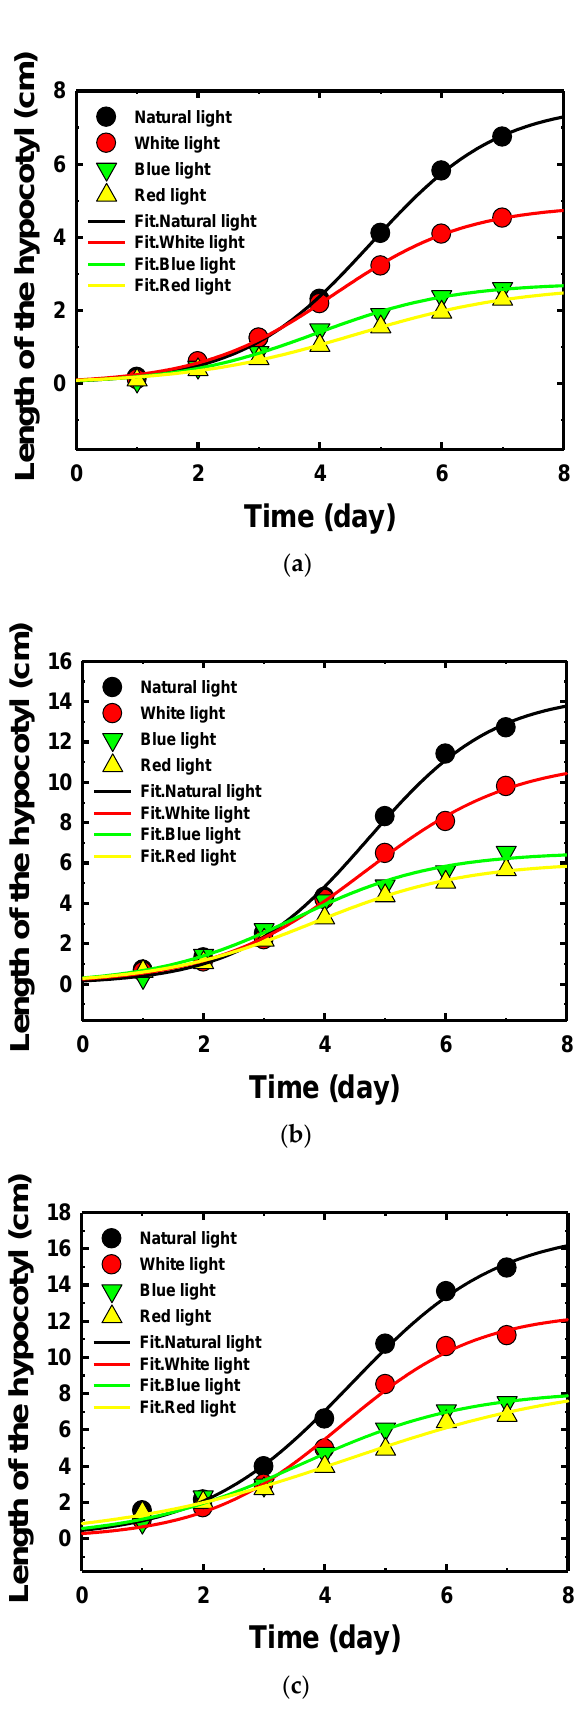
Figure 9. Comparison of the effect of four light spectra between length groups of hypocotyls: ( a ) short (group A); ( b ) medium (group B); ( c ) long (group C). Table 3. Criteria dividing stem lengths into 3 groups.